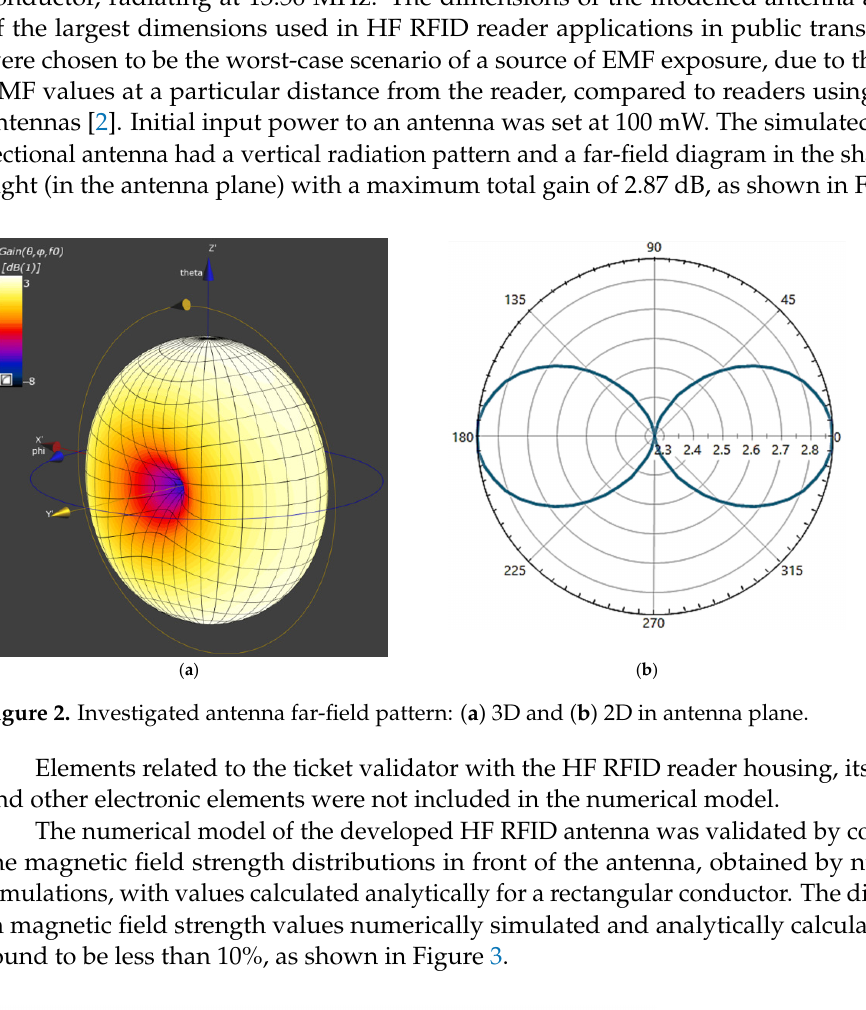
metal vehicle cabin